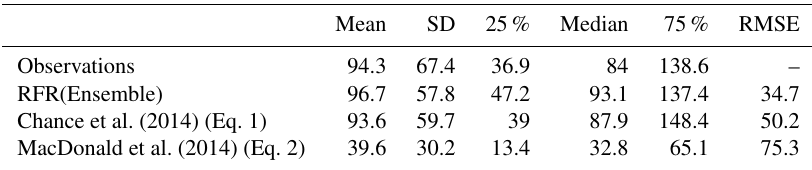
Table A3. Statistics on observations and predicted values by ensemble and existing parameterisations at locations of observations but just for the withheld dataset locations. Table 3 shows the values for both the withheld and entire